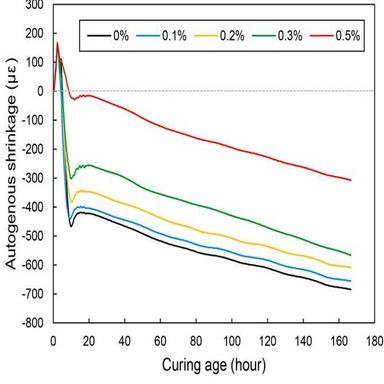
Autogenous shrinkage development of the samples for 165 h after final setting.